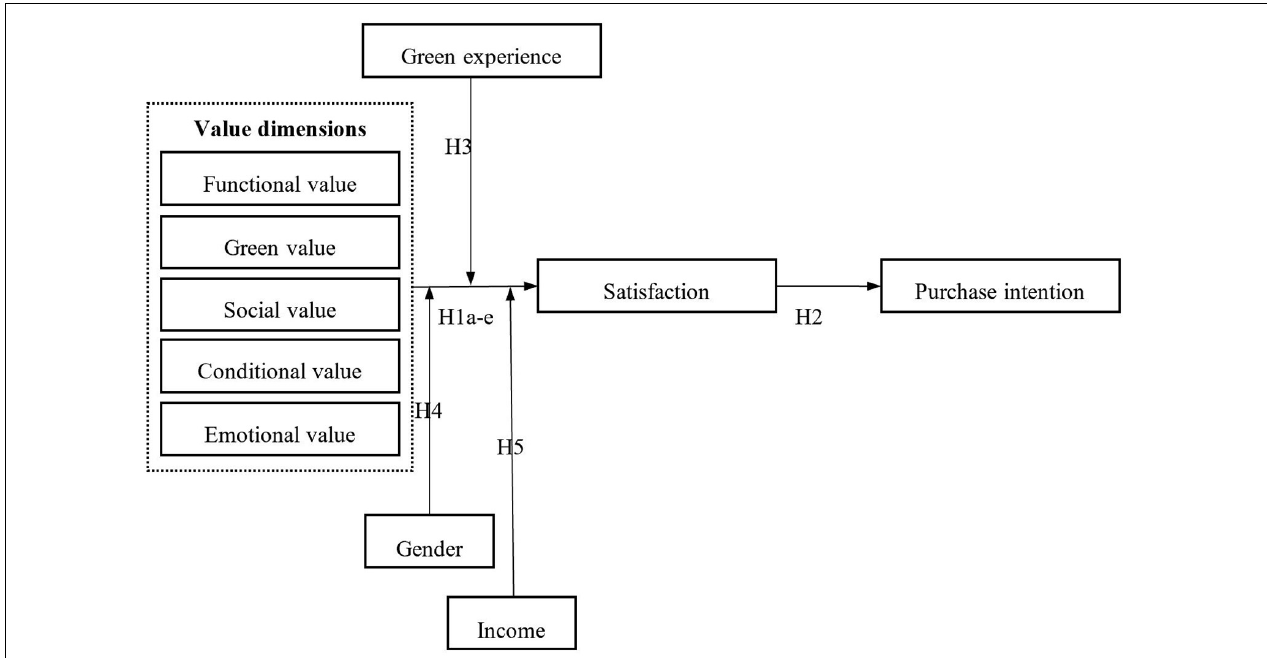
FIGURE 1 | Research